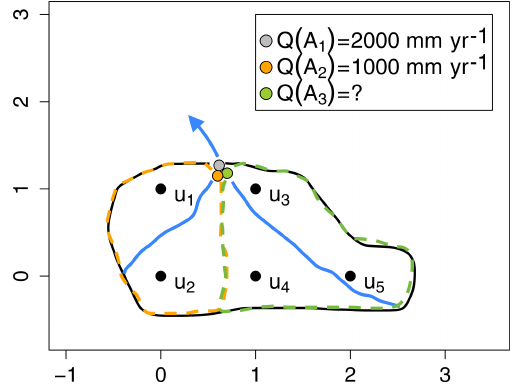
Figure 6. Conceptual, simplified figure of a river network, for which the involved catchments are discretized by 5 grid nodes u 1 ,..., u 5 , and each grid node represent one areal unit. Catch- ment A 1 contains all grid nodes u 1 ,..., u 5 , Catchment A 2 con- sists of grid nodes u 1 and u 2 , while Catchment A 3 consists of grid nodes u 3 , u 4 and u 5 . Hence, this is a system of nested catchments where A 1 covers A 2 and A 3 . Assume that there are observations of annual runoff at the outlet of catchment A 1 and catchment A 2 : Q( A 1 ) = 2000mmyr − 1 and Q( A 2 ) = 1000mmyr − 1 . Catchment A 3 is ungauged. In order to fulfill water balance constraints of the areal model from Eq. (11), imposed by the likelihood in Eq. (7), the predicted mean annual runoff in catchment A 3 must be around 2667mmyr − 1 if we assume a low observation